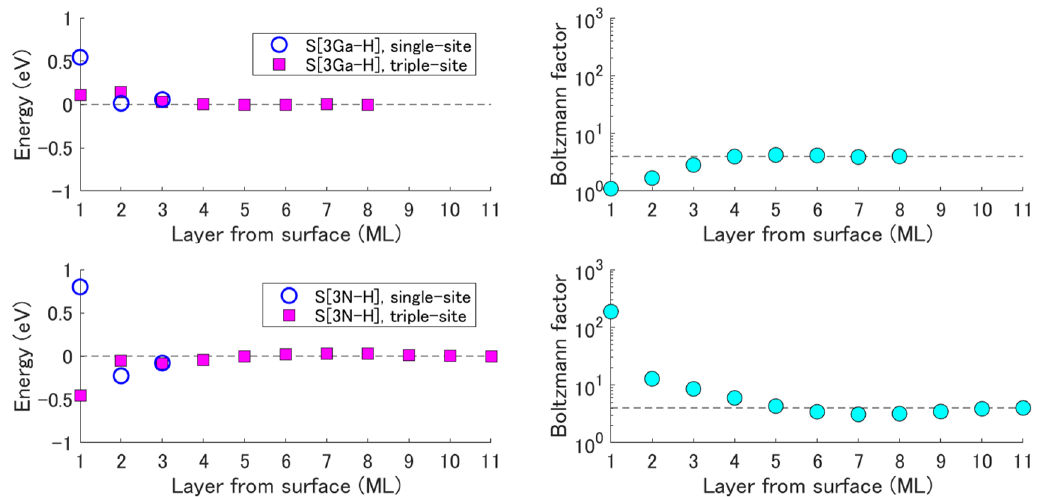
Figure 7. Depth profiles of the C impurity energy in (0001) and (000−1) as reported in Reference [51]. Weighted sum of Boltzmann factors (i.e., the sum of the triple one for the triple-site and the one for the single-site) at 1000 °C calculated from the energies.